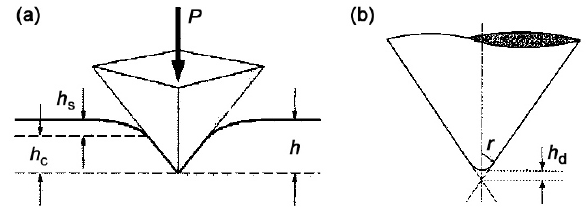
Fig. 1 Schematic diagrams showing (a) h = h c + h s and (b) the geometry of a rounded indenter tip.